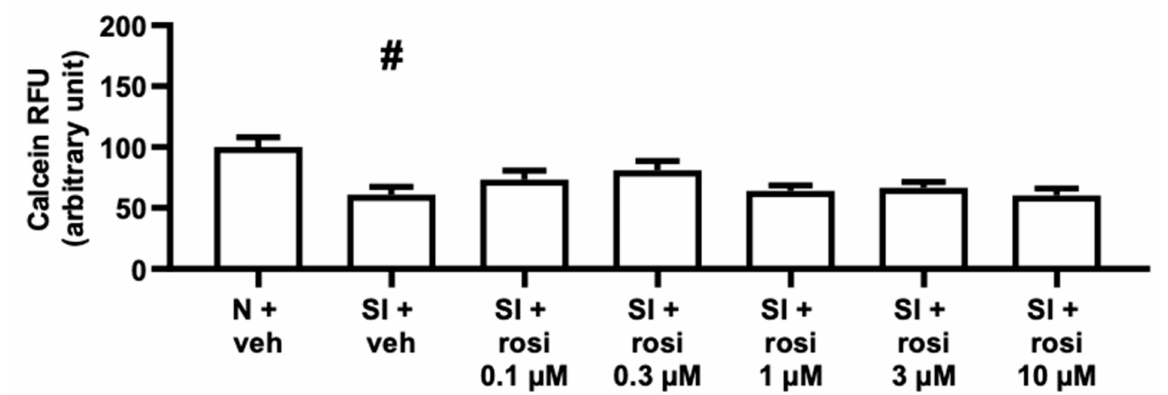
Figure 8. Differentiated AC16 cell line viability under normoxic and simulated ischemic conditions with or without varying concentrations of rosiglitazone. Results are presented as mean with standard error. The N + vehicle group was set to 100% RFU, and all data were normalized to the averaged medium-treated group. Rosiglitazone treatment did not aggravate cell death due to simulated ischemia in differentiated AC16 cells. (Kruskal–Wallis, Dunn’s post hoc, # p < 0.05 vs. N + vehicle. n = 4, 21–22 technical replicates). SI: simulated ischemia; N: normoxia; veh: vehicle; rosi: rosiglitazone; RFU: relative fluorescence